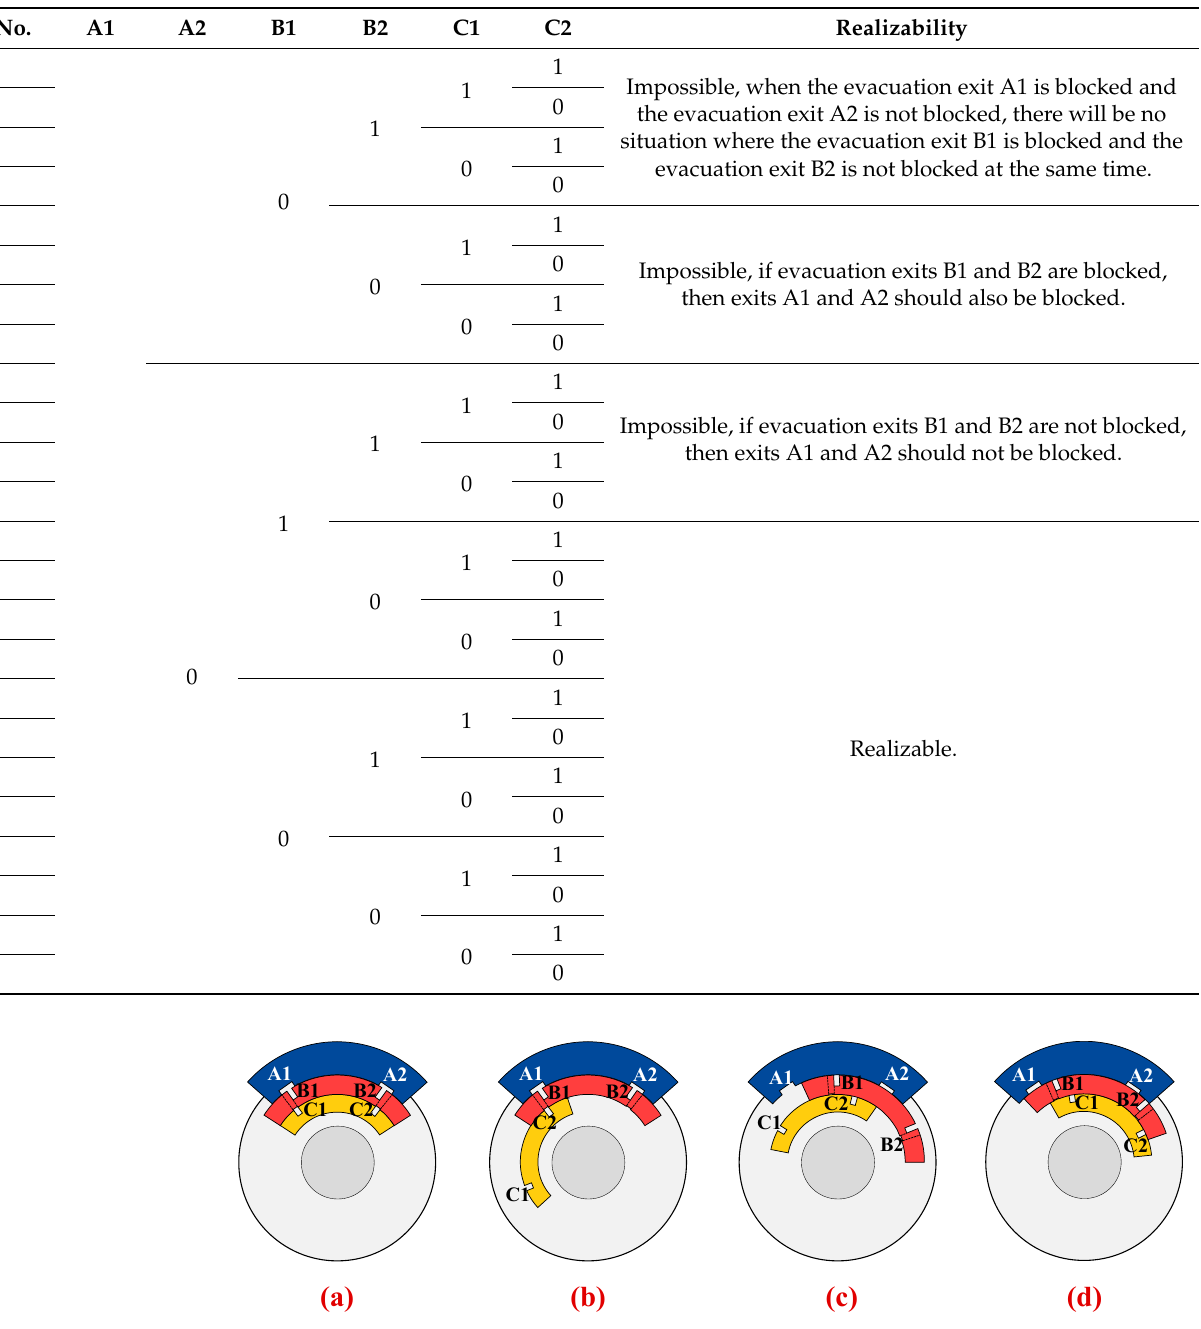
Figure 8. Four typical auditorium rotation situations. ( a ) Audience rotation situation 1; ( b ) Audience rotation situation 2; ( c ) Audience rotation situation 3; ( d ) Audience rotation situation 4.